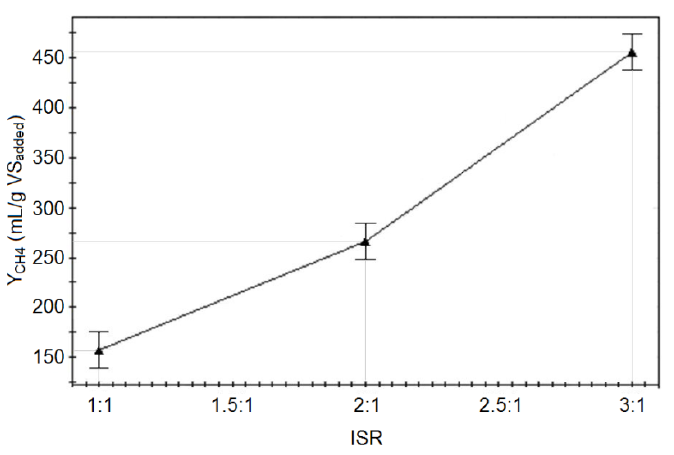
Figure 1. Main effect plot: predicted influence of ISR on the specific methane yield when all other factors are held constant at their